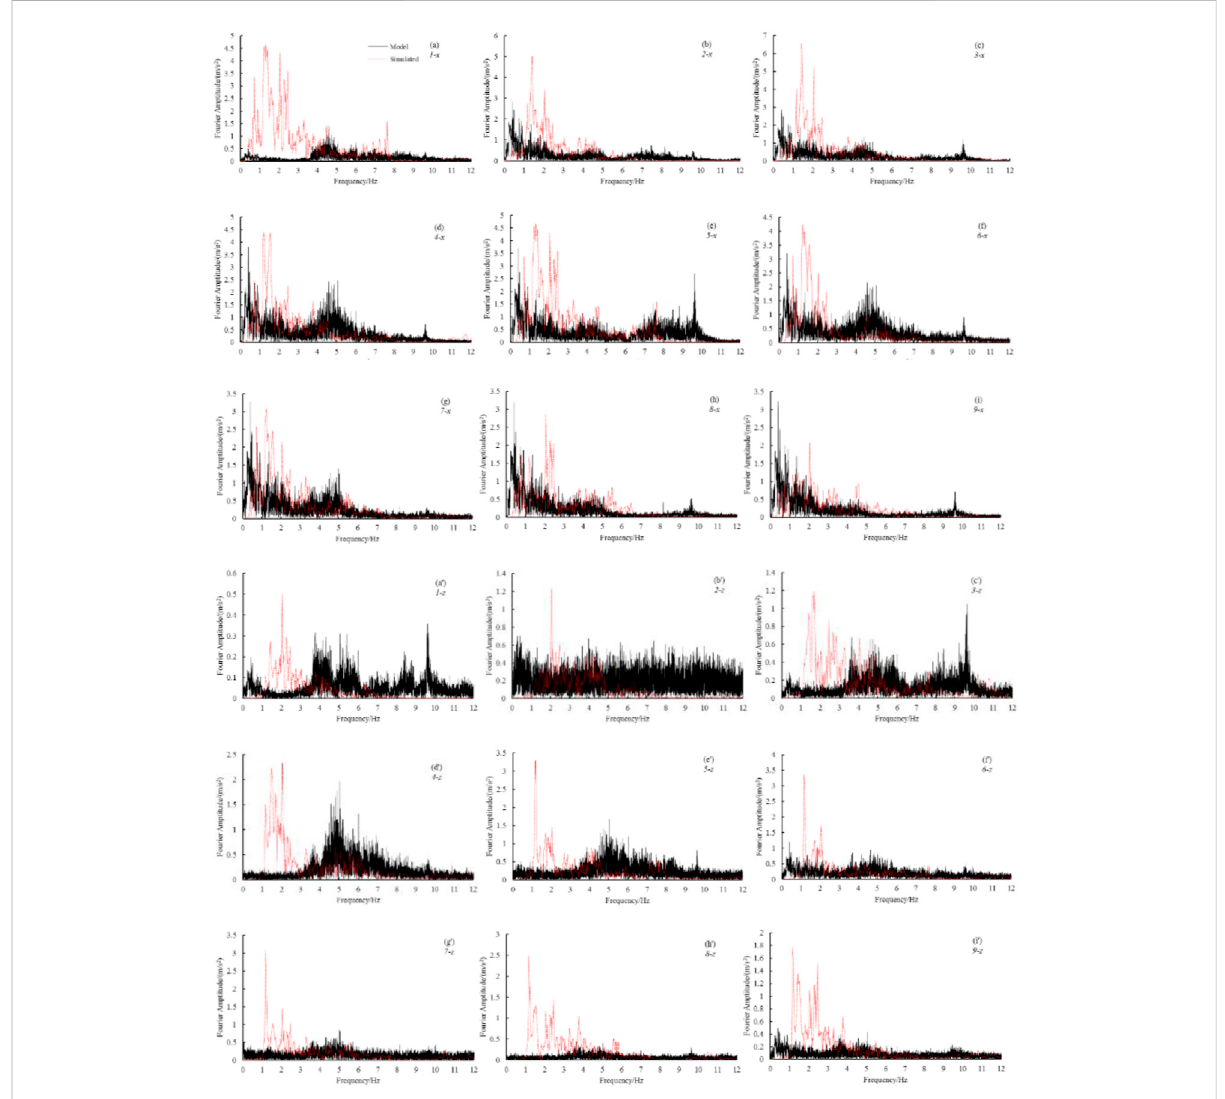
FIGURE 16 Fourier spectrum of each measuring point of the slope in the model test and numerical